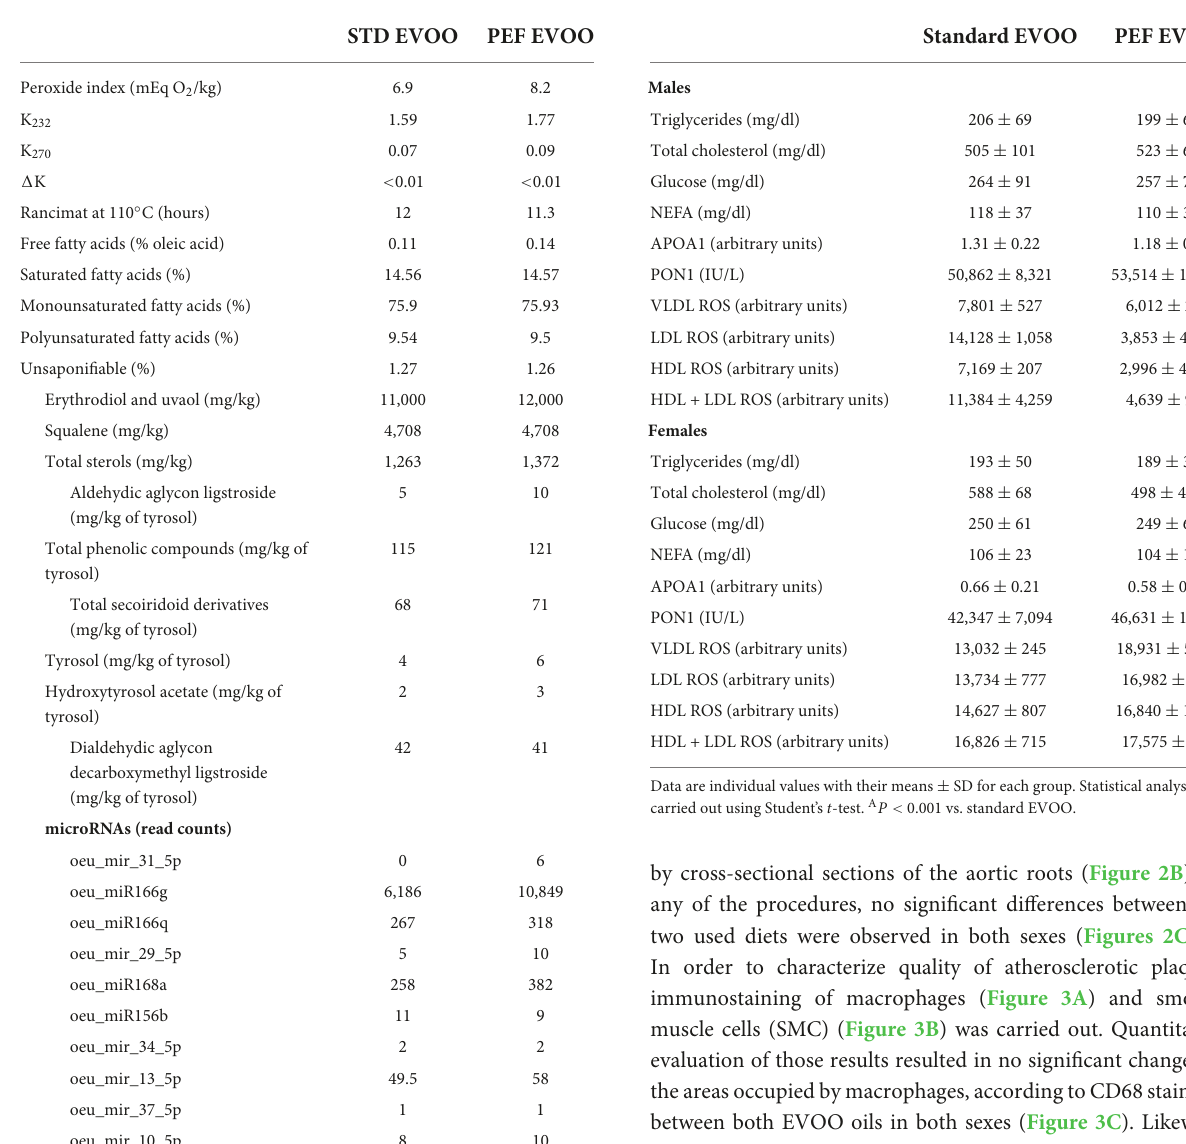
TABLE 1 Main differences in chemical composition of used EVOO. TABLE 2 Plasma parameters.